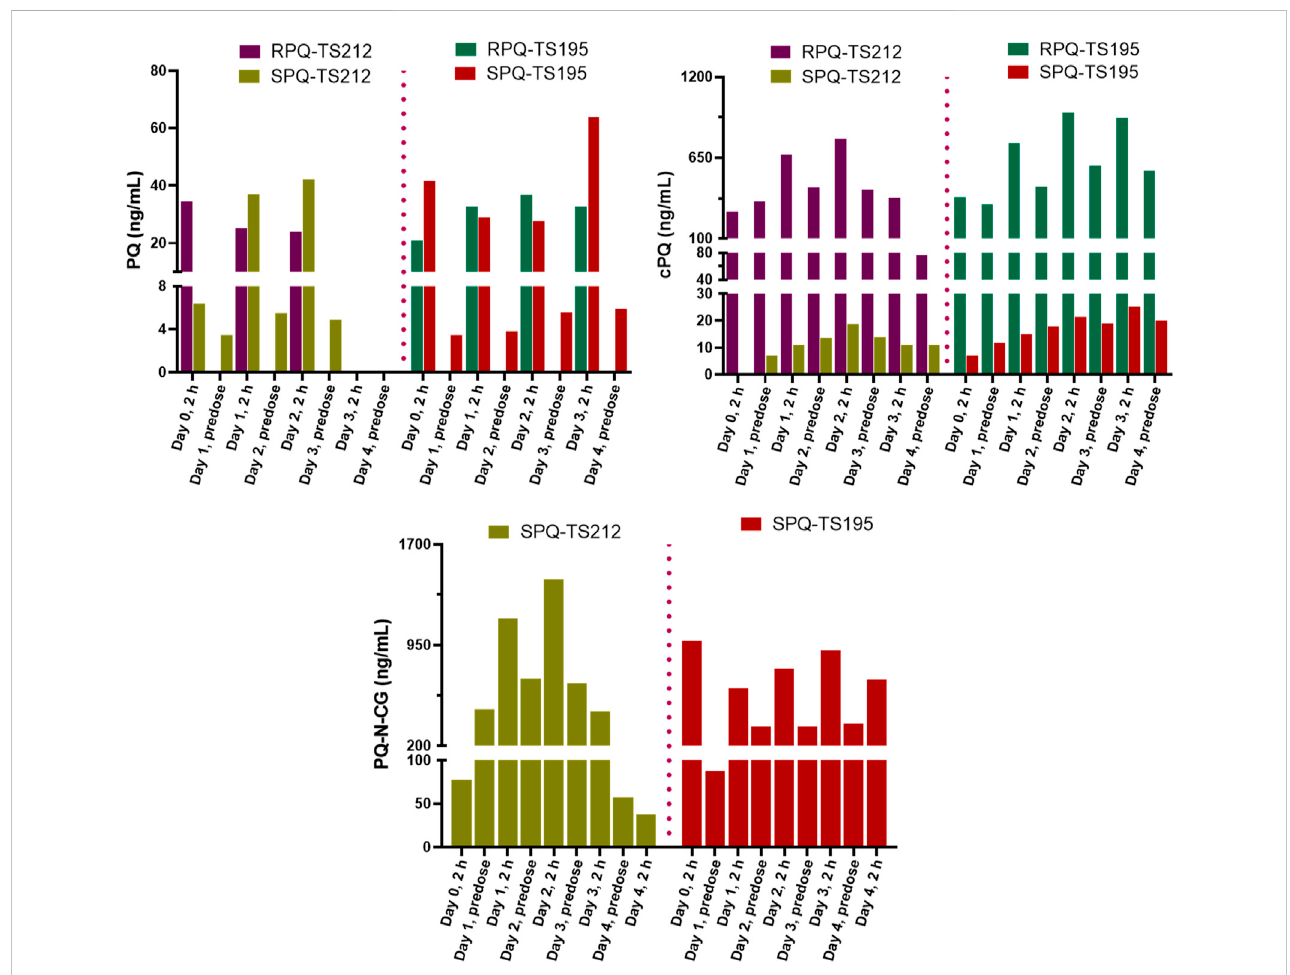
Concentrations of PQ and its metabolite in plasma of G6PDd subjects during daily oral administration of the individual enantiomers of